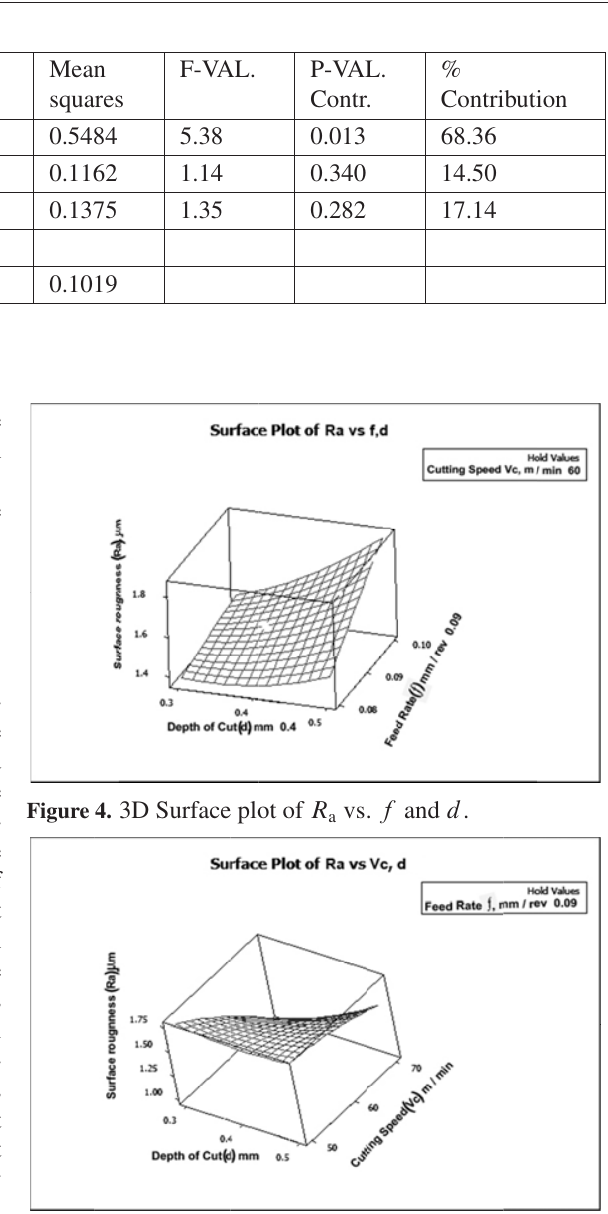
Figure 5. 3D Surface plot of R a vs. V c and d .